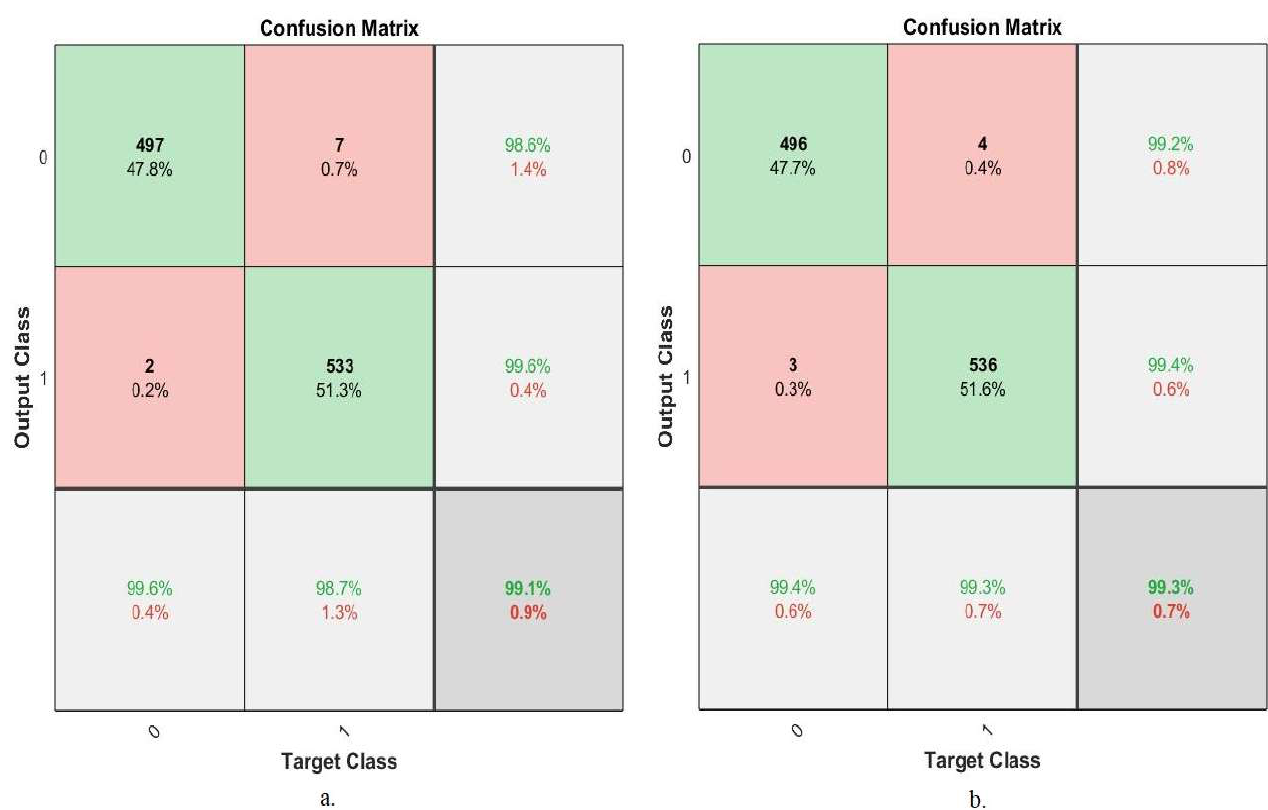
Figure 12. Confusion matrix for evaluating ANN performance based on hybrid features. ( a ) AlexNet, DWT, LBP, FCH, and GLCM; ( b ) ResNet-18, DWT, LBP, FCH, and GLCM.